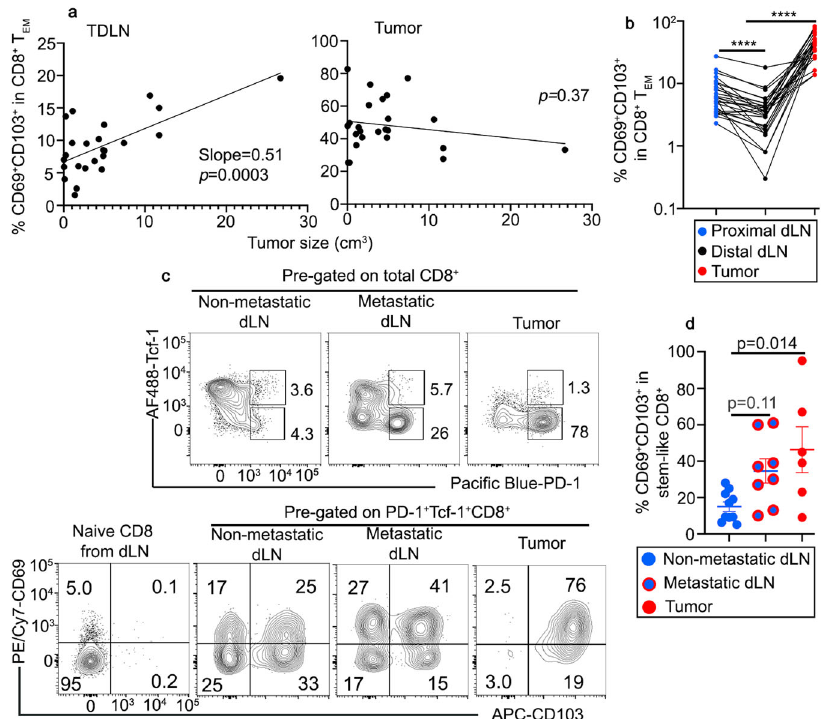
Fig. 10 | Stem-like CD8 + T cells differentiate into T RM -like cells in TDLN of human head and neck cancer patients. a The association of CD69 + CD103 + % in total CD8 + T EM isolated from proximal TDLN (left) and tumor (right) are shown ( n =24 individual patients). Simple linear regression was performed. b The per- centageofCD69 + CD103 + cellsintotalCD8 + T EM isolatedfromproximalTDLN,distal LNandtumorfromthesamepatients( n =28patientswiththreesamplesfromeach patient). c Top,representativeFACSpro fi lesoftotalCD8 + Tcellsisolatedfromnon- metastaticTDLN,metastaticLNandtumorareshown;bottom,comparedwithTCF- 1 + PD-1 − CD45RA + naiveCD8 + Tcells,FACSpro fi lesofpre-gatedTCF-1 + PD-1 + stem-like